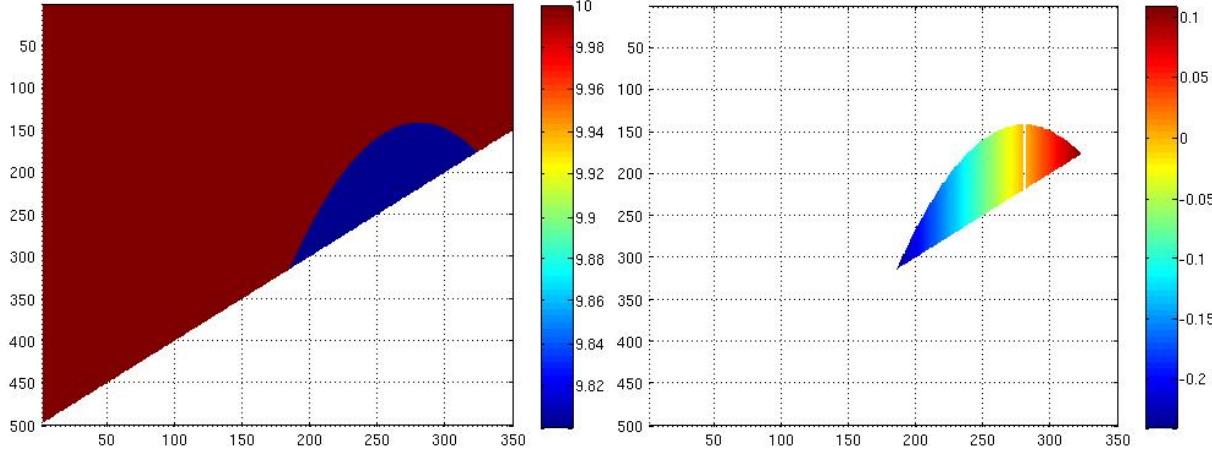
Fig. 1. Initial condition: temperature (left) and geostrophically adjusted velocity u (cross stream component; y-direction is upslope). the first level is at only 0.3 m from the ocean floor (measured at the upslope side of the domain). Experiment G02 is thus of higher quality than G01 due to the grid refinement near the ocean floor. In other experiments the resolution is varied in the vertical zones defined above (Z1, Z2 and Z3) to evaluate the lack of resolution in the different zones, each one being representative of different physical processes. For the grids with three levels in the zone Z1 the first three horizontal- velocity grid points are at 2.5 m, 10 m and 22.5 m from the ocean floor resolution (on the up slope side of the domain).